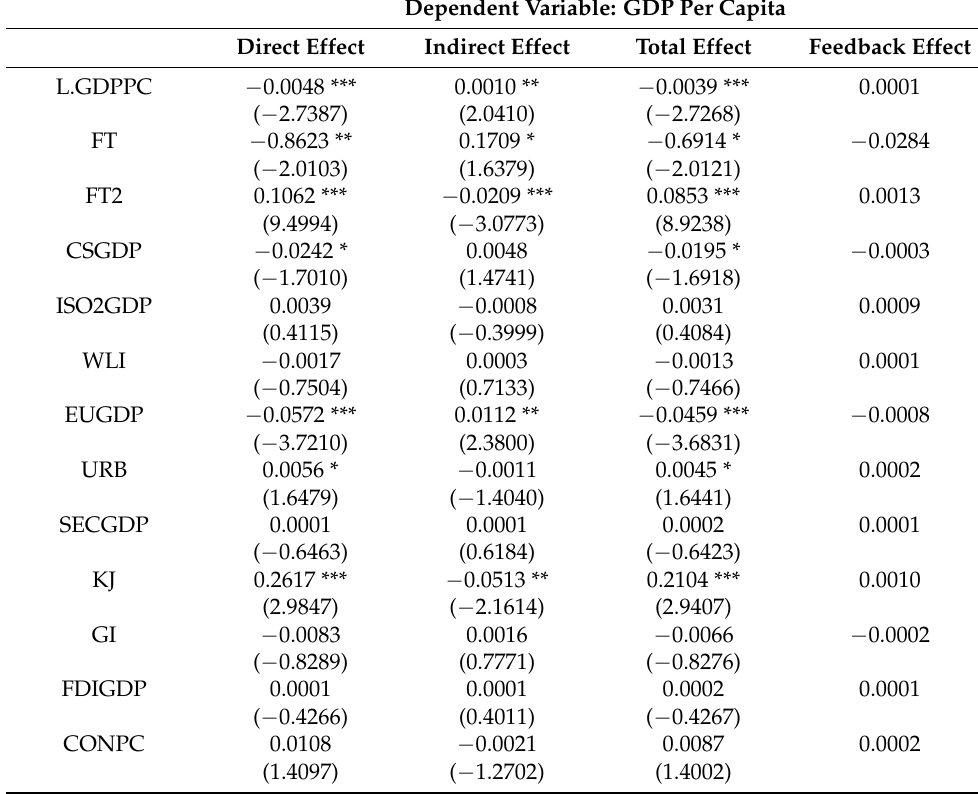
Table 6. Decomposition of direct effects, indirect effects, and total